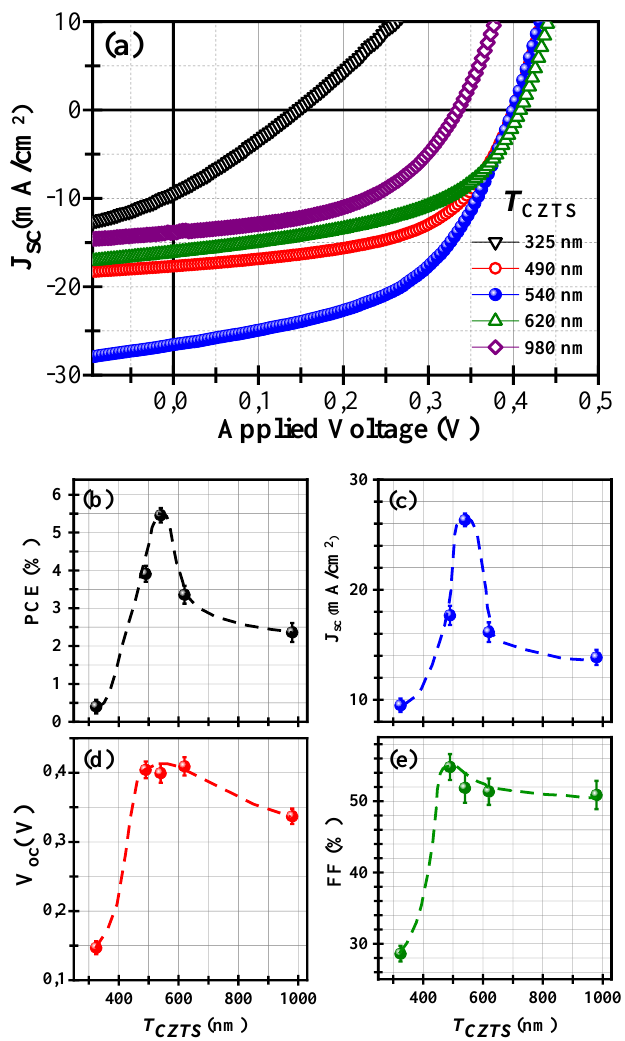
Figure 5. ( a ) J-V characteristics of the CZTS / SiNWs PV-devices as a function of the CZTS film thickness ( T CZTS ); ( b – e ) T CZTS dependence of the PV parameters (PCE, J SC , V OC and FF) of the CZTS / SiNWs solar cells.